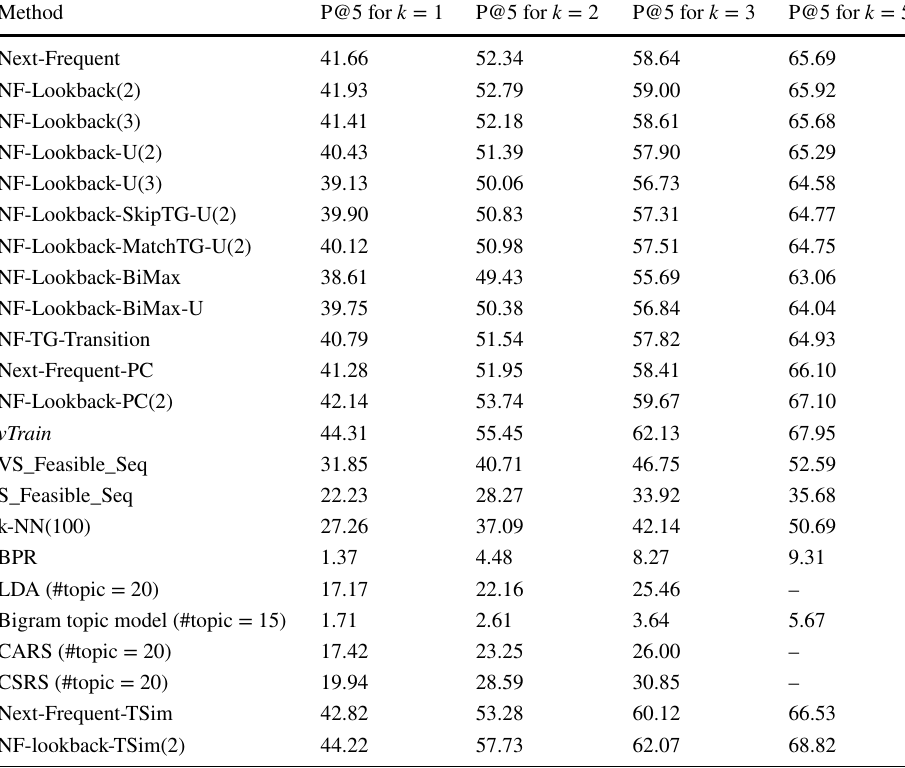
Table 7 Comparison of various methods for predicting next training